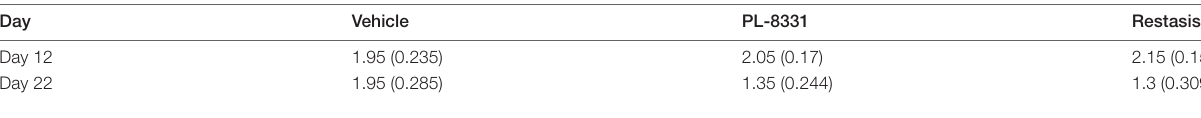
FIGURE 5 | Corneal fluorescein staining in mice with chronic dry eye (SiccaSystem TM model). Data are presented as median ± interquartile range; data were compared by paired non-parametric Wilcoxon test. ∗ Significant difference; see P -values under x-axis. Mean (SEM)